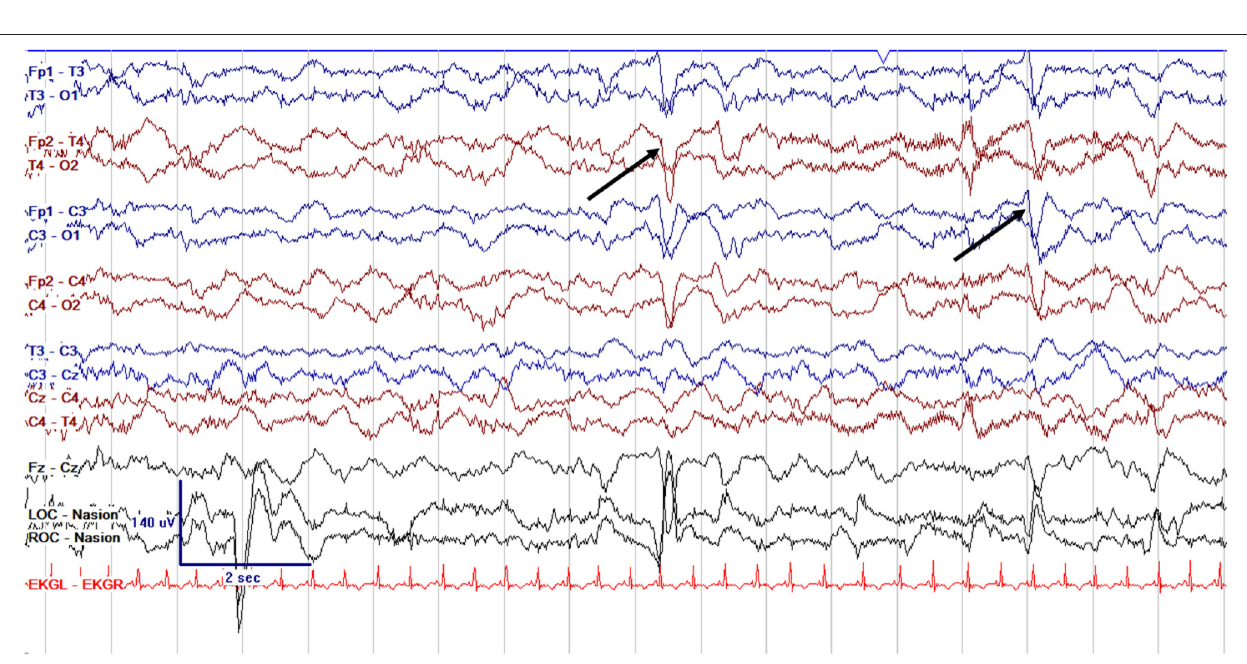
(8). In another study, severe background abnormalities on EEG (discontinuous activity with interburst intervals 10–60 s, severe attenuation of background activity, no sleep-wake cycles,